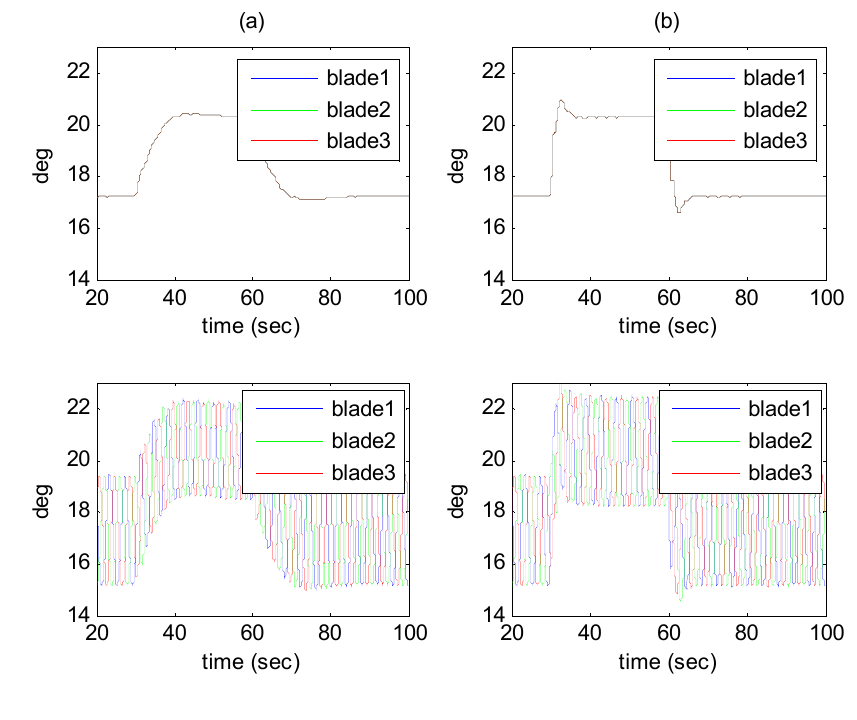
Figure 10. Turbulent wind speed